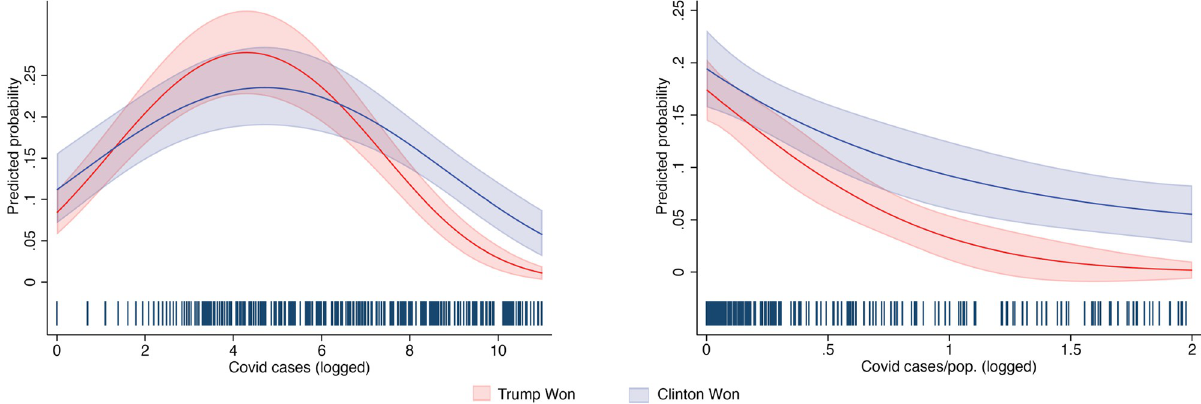
Fig 3. Whence the fear, politics or epidemiology? (V). Note : N = 3,650; Log Lik. = -1107.12.